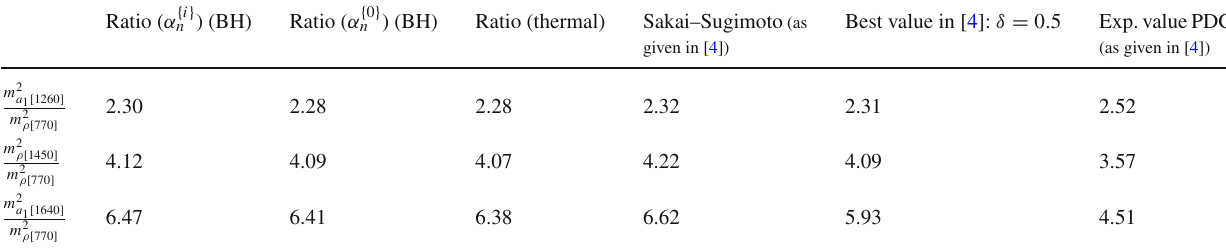
Table 7 Comparison of mesons masses ratio { i } Ratio ( α n )